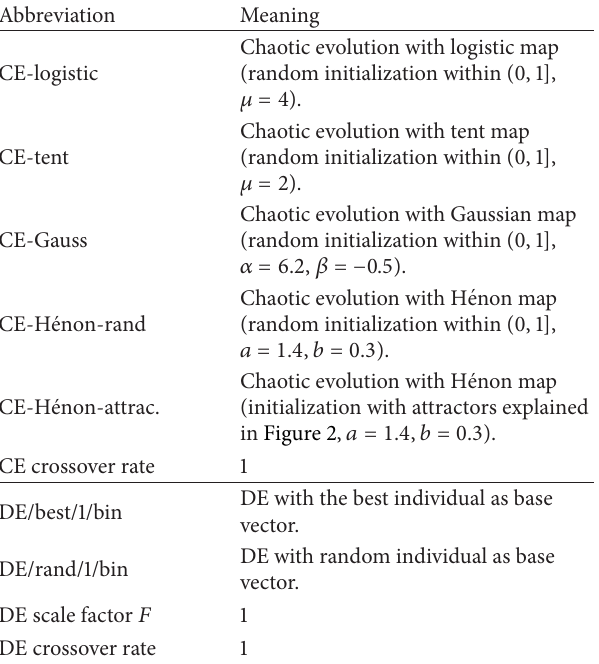
Table 2: Algorithm parameter setting and abbreviations of the algorithms used in